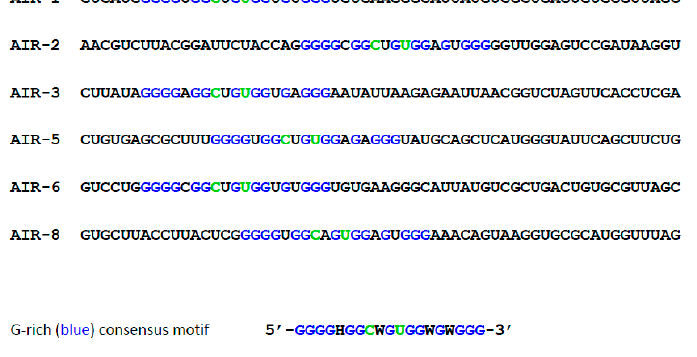
Figure 1. Alignment of interleukin-6 receptor (IL-6R) aptamer sequences from enriched pools. Consensus sequence is given below (conserved Gs in blue and conserved Cs and Us in green ); H encodes A, C, or U and W encodes A or U, respectively. Flanking primer binding sites or constant regions of starting pool are omitted.